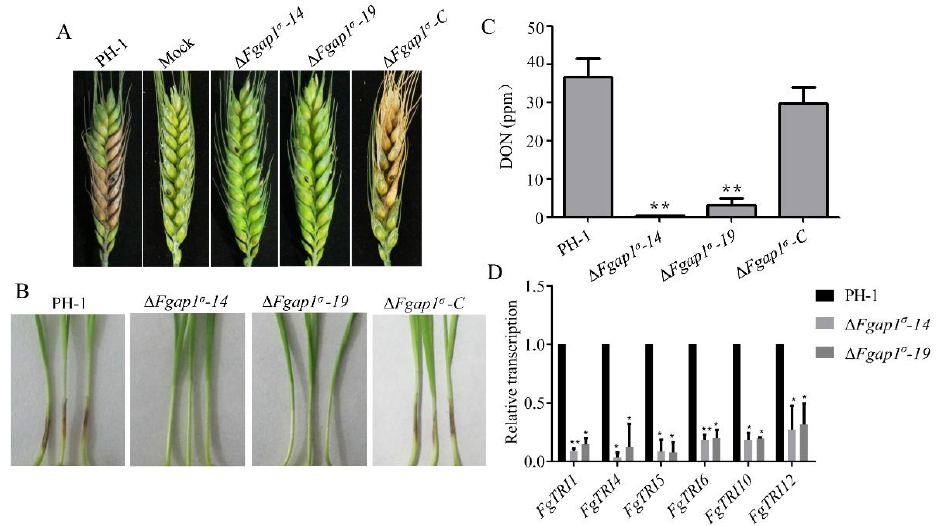
Figure 4. FgAP1 σ is required for virulence. ( A ) Pathogenicity of ΔFgap1 σ mutants on flowering wheat heads was significantly reduced compared with the wild-type PH-1 and ΔFgap1 σ -C strains. Mycelia plugs from the various strains were inoculated on flowering wheat heads under moist conditions, and disease symptoms were recorded after two weeks. ( B ) The pathogenicity of ΔFgap1 σ mutants on wheat coleoptiles was abolished. ( C ) Level of deoxynivalenol (DON) production by ΔFgap1 σ mutants. Mycelia of the indicated strains were dried and weighed to quantify the fungal biomass. Level of significance was measured using an unpaired t -test (** p < 0.01). ( D ) The expression levels of some trichothecene biosynthetic genes FgTRI were significantly reduced in the ΔFgap1 σ mutants. Level of significance was measured using an unpaired t -test (* p < 0.05, ** p < 0.01).